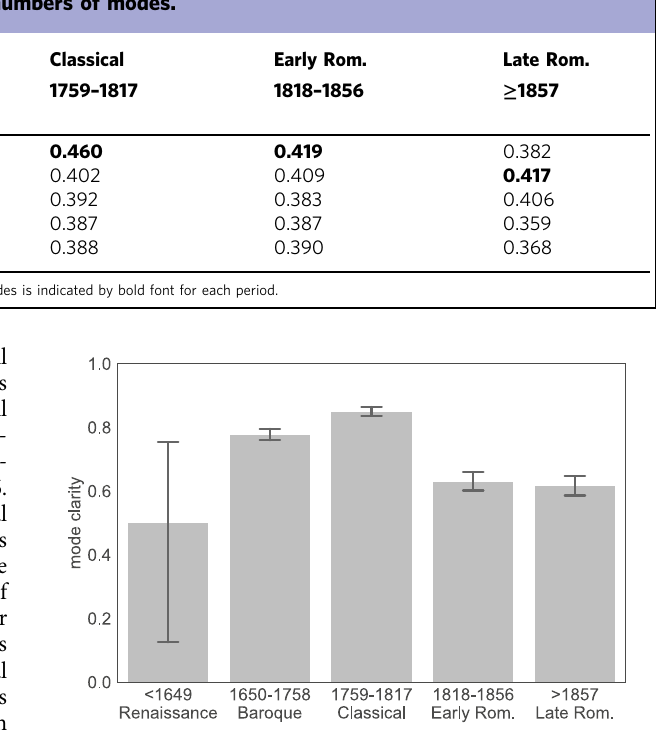
Fig. 5 Mode clarity values for each time period (proportion of correctly predicted modes according to the key labels in the metadata). The error bars show 95% bootstrap con fi dence intervals. The values con fi rm the clear distinction between major and minor in the Baroque and the Classical period. In the Romantic periods, this separation is still existent, but not as clear as before. The mode clarity of the Renaissance period is not quanti fi able due to the small amount of pieces in this